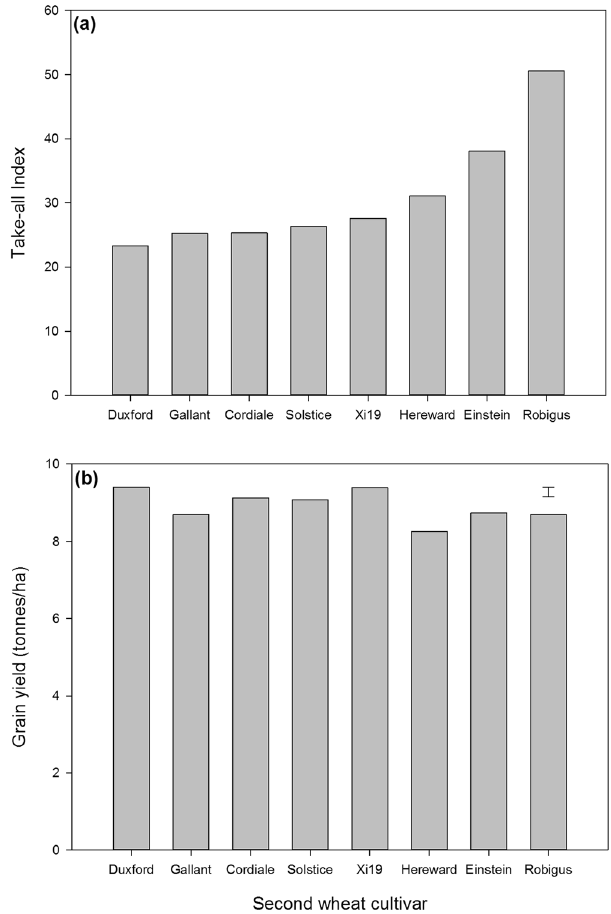
Figure 3. Take-all severity ( a ) and grain yield ( b ) of eight winter wheat cultivars sown as a second wheat crop in the rotation in a combined analysis of the four rotational field experiments (Logit of the take-all index F Pr < 0.001; Grain yield, F Pr < 0.001). In panel (a) the back-transformed means on the take-all index scale are shown (Logit of the take-all index; Duxford = − 0.596, Gallant = − 0.542, Cordiale = − 0.540, Solstice = − 0.515, Xi19 = − 0.482, Hereward = − 0.399, Einstein = − 0.243, Robigus = 0.011, SED = 0.106). The error bar in panel (b) shows the standard error of the difference between the